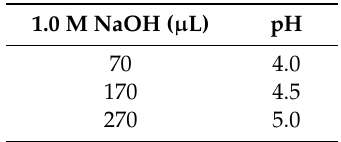
Table 2. The amount of 1.0 M NaOH ( µ L) added for determining the radiolabeling e ff ect on